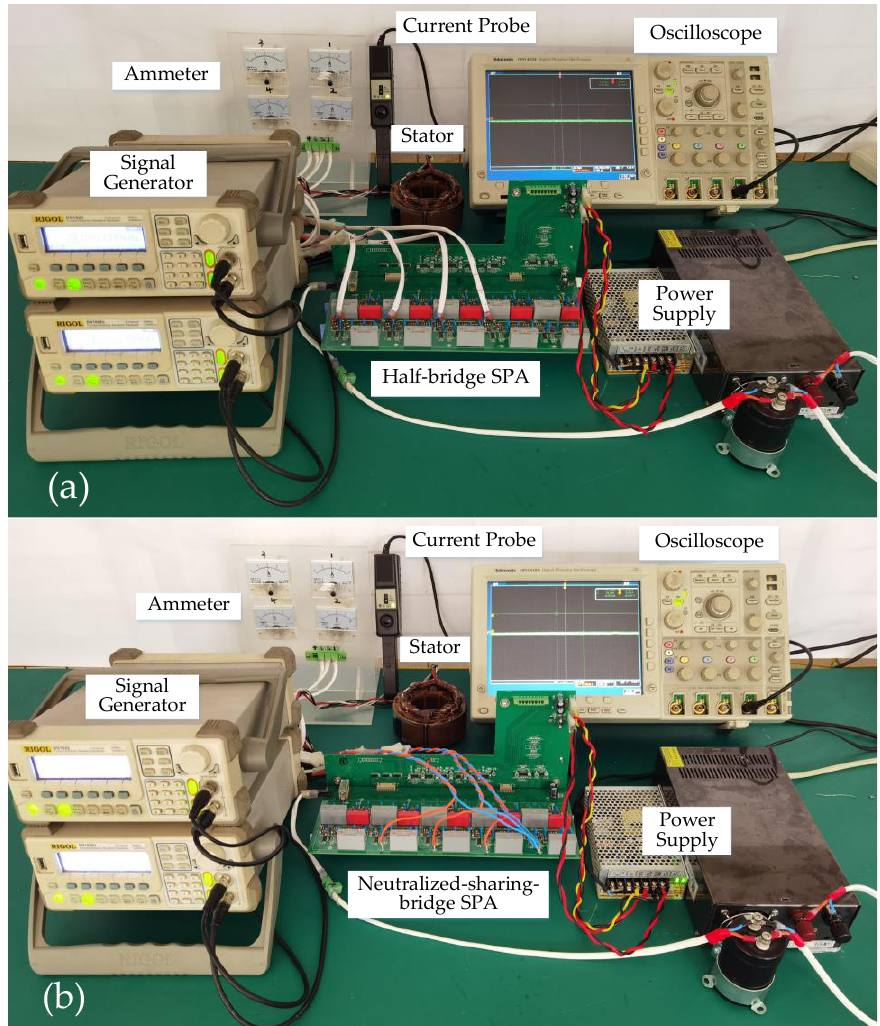
Figure 17. Experimental setup with ( a ) half-bridge SPA, ( b ) neutralized-sharing-bridge SPA.